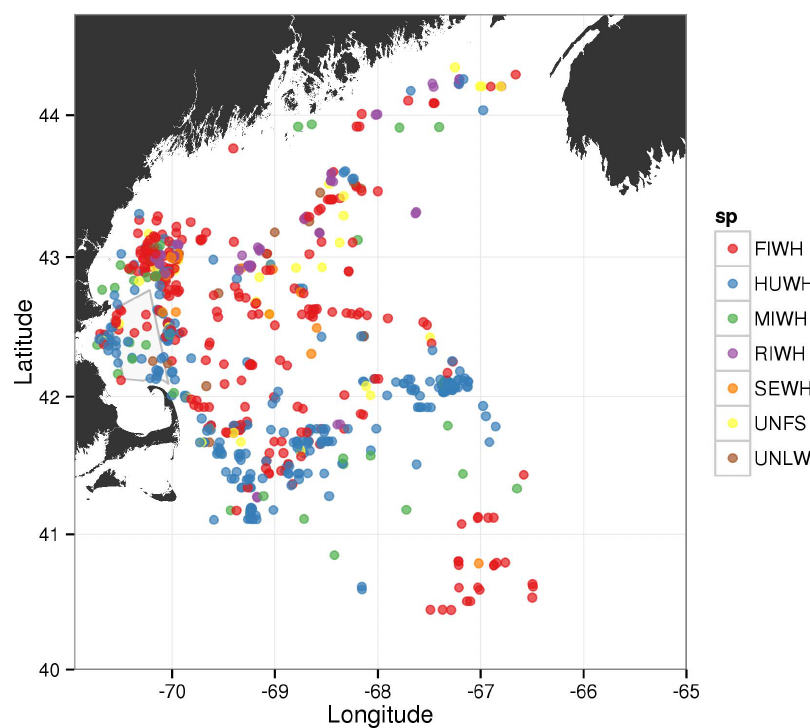
Figure 1. Sightings of baleen whales in the Gulf of Maine during right whale aerial surveys conducted by the Northeast Fisheries Science Center (NEFSC) during September 15 to October 17, for years: 1998, 2002–2008 and 2010. FIWH = fin whale, HUWH = humpback whale, MIWH = minke whale, RIWH = right whale, SEWH = sei whale, UNFS = unidentified fin or sei whale, UNLW = unidenitified large